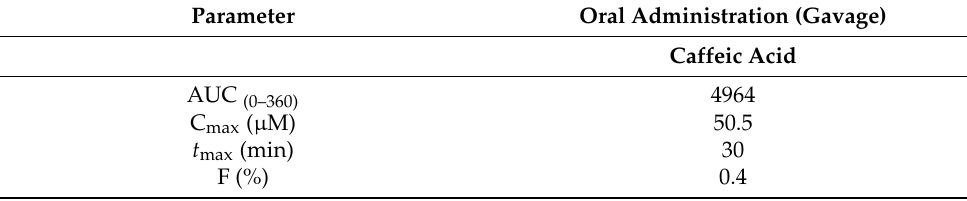
Figure 7. Pharmacokinetic study of caffeic acid (CA) and ferulic acid (FA) after oral administration of CA (25 mg/kg) in 3 days-UUO mice. ( A ) Plasma concentration–time profiles of CA and its circulation metabolite, ferulic acid (FA), in UUO mice. ( B ) Corresponding area under the curves (AUC) of CA and FA in plasma. ( C ) Concentration–time profiles of CA and FA in obstructed and contralateral kidneys. ( D ) Corresponding area under the curves (AUC) of CA and FA in obstructed and contralateral kidneys. Concentrations were determined using UPLC-HESI-Q-orbitrap (Q-Exactive™ Plus). *** p < 0.001, **** p < 0.0001, compared to UUO + Vehicle; $$$$ p < 0.0001, compared to caffeic acid; §§ p < 0.01, §§§ p < 0.001, §§§§ p < 0.0001, compared to contralateral kidney; ££££ p < 0.0001, compared to caffeic acid. Values are means ± SD; n = 3 animals/time. Table 4. Pharmacokinetic parameters at the dose 25 mg/kg of caffeic acid (CA) orally administered in UUO mice. AUC represents the calculated area under the curve between 0 and 360 min. C max is the maximum concentration achieved. t max is the required time to achieve C max . Bioavailability (F) is the fraction of the administered dose that is available to the systemic circulation. Values are means; n = 3